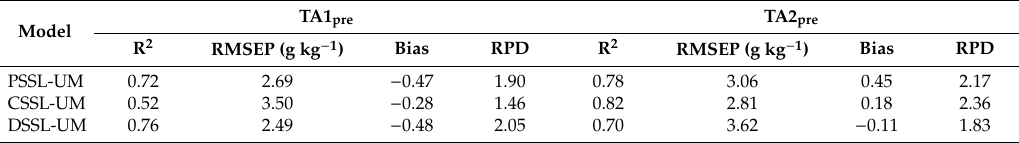
Table 5. Statistical results of prediction performance of the unspiked models (UM). RMSEP, root mean square error of prediction; RPD, residual predictive